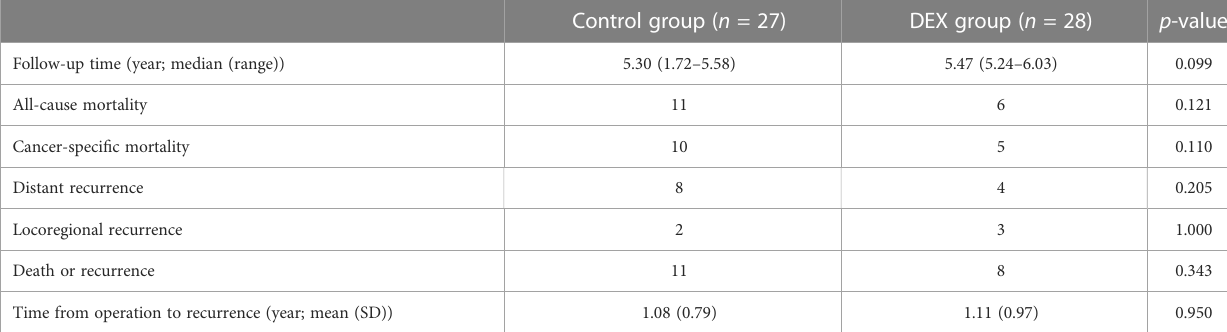
TABLE 4 Mortality and cancer recurrence.